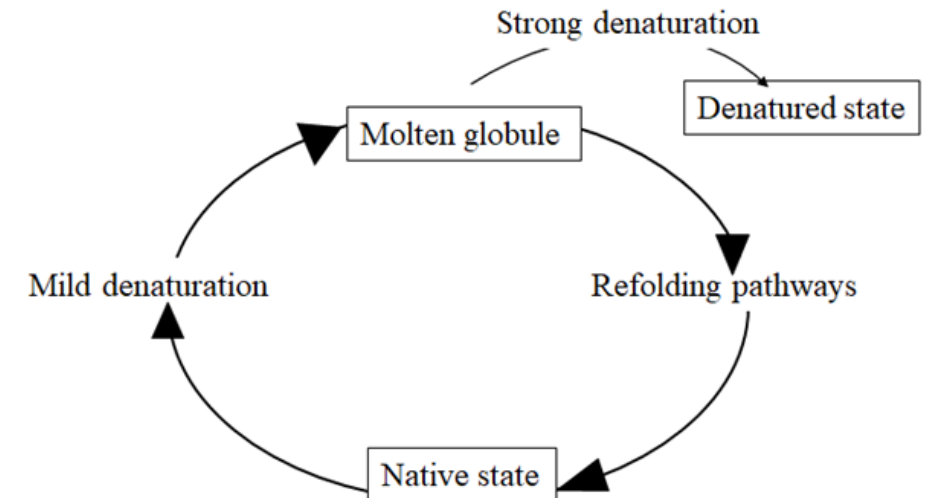
Figure 1. Molten globule. The molten globule is a protein state which is different from both the native state and the denatured state. It is an intermediate lacking the compaction of side chains as in the native state of a protein. Molten globules are collapsed and exhibit a native secondary structure with a dynamic tertiary structure. These features are that observed in the transient intermediates during the folding of globular proteins that present collapsed hydrophobic region.